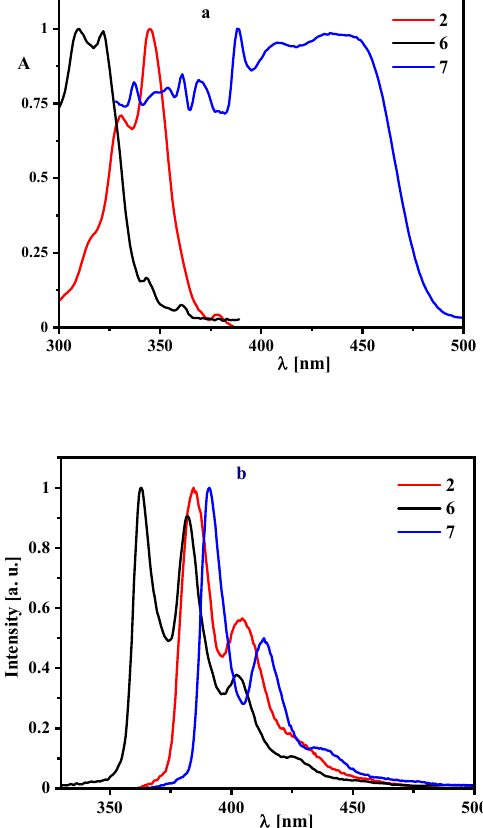
Figure 4. Normalized absorption ( a ) and emission ( b ) spectra of 2 , 6 , and 7 in chloroform, C = 5 × 10 − 6 M. Excitation at 345 nm ( 2 ), 343 nm ( 6 ) and 354 nm ( 7 ). Table 1. Photophysical data of compounds 2 , 6 and 7 .